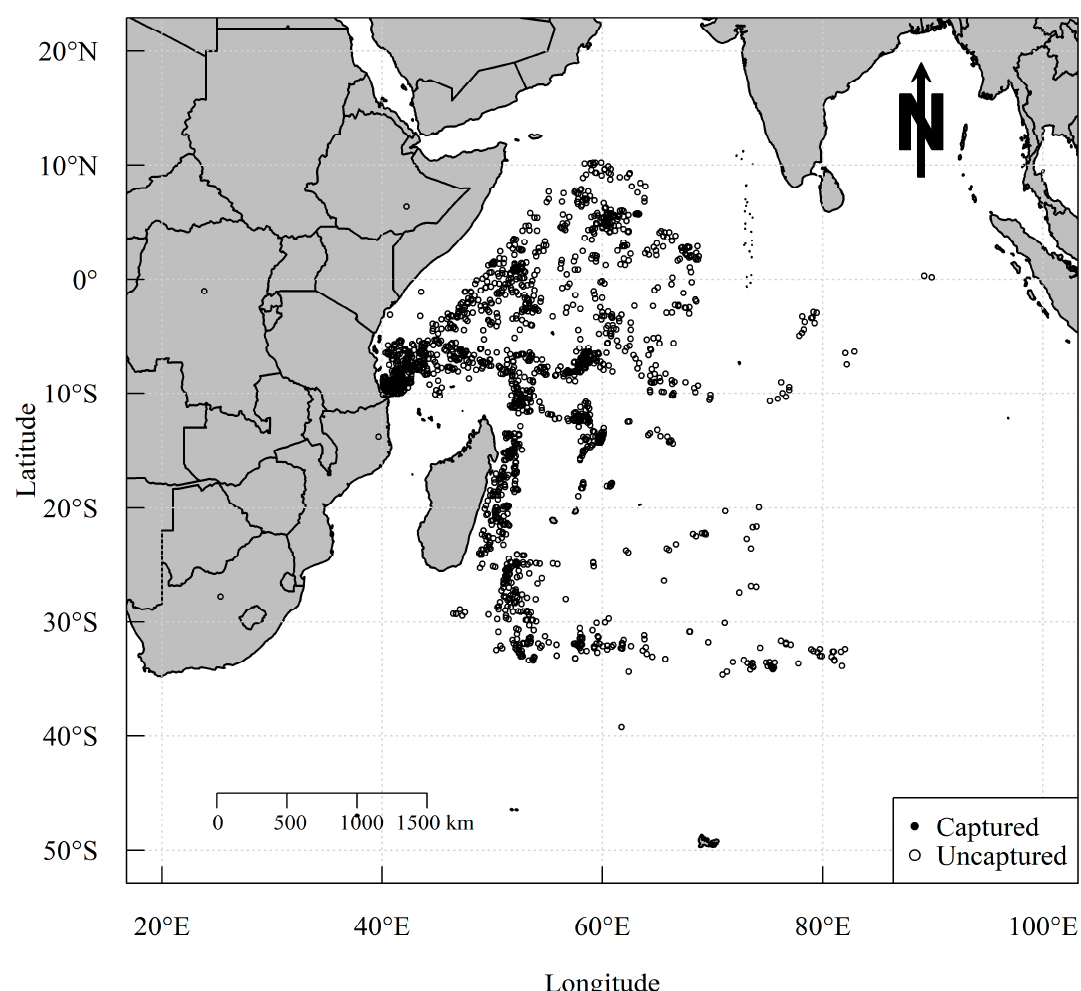
Figure 1. The location distribution of longline fishing survey sites in the China Ocean Fisheries Observer Program from 2012 to 2018.